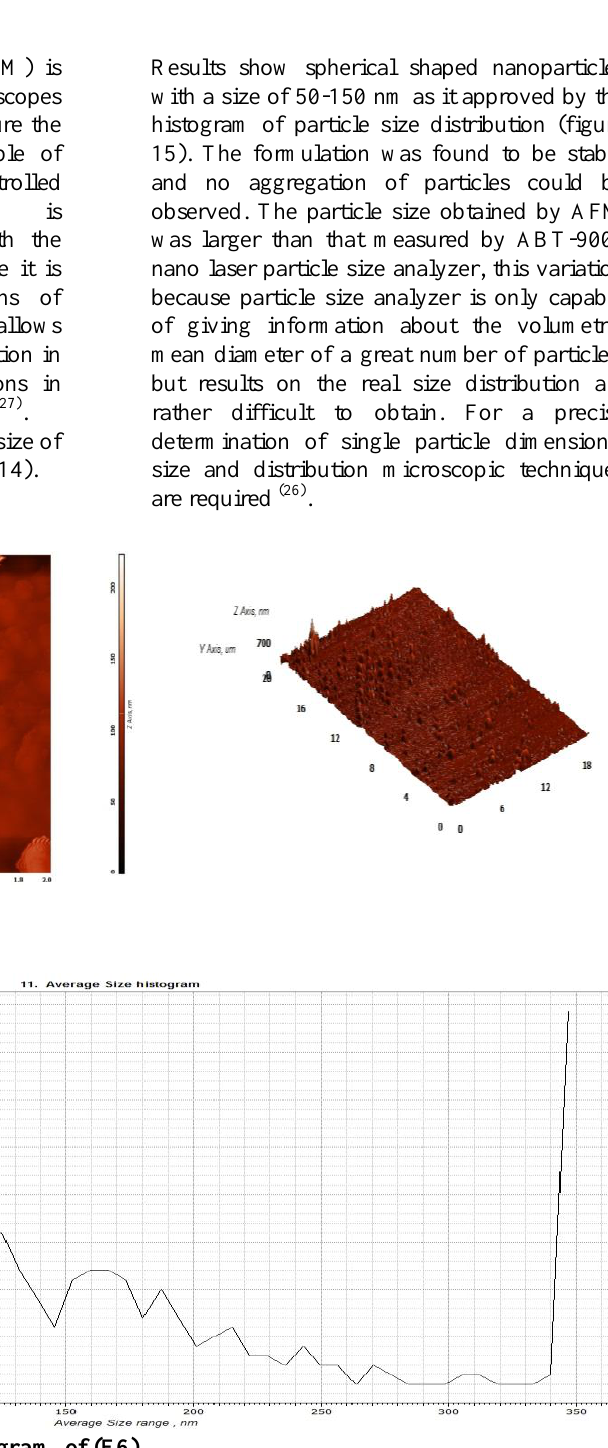
Figure 15: AFM average size histogram of